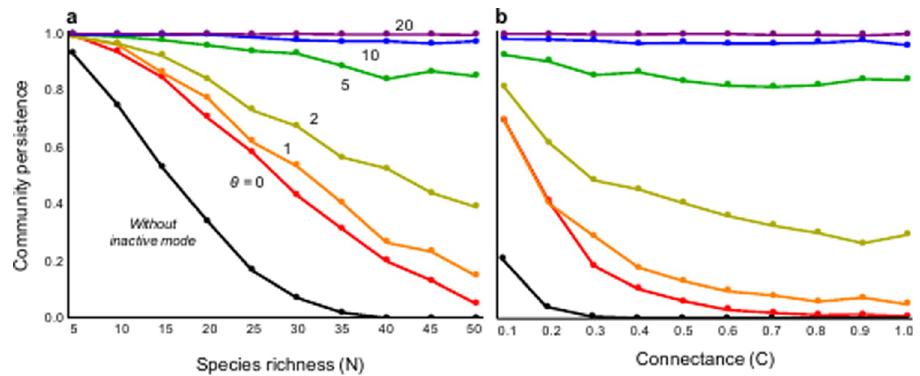
Fig 3. Relationships between food web complexity and stability. (a) Effects of species richness (N), C = 0.3; (b) Effects of connectance (C), N = 40. See S8 Fig. for the confidence interval. Black lines represent cases with no inactive mode. Color represents different values of θ . Parameters are R = 0.04, E = 0.01, A 1 = 0.1, A 2 = 0.01, and G =